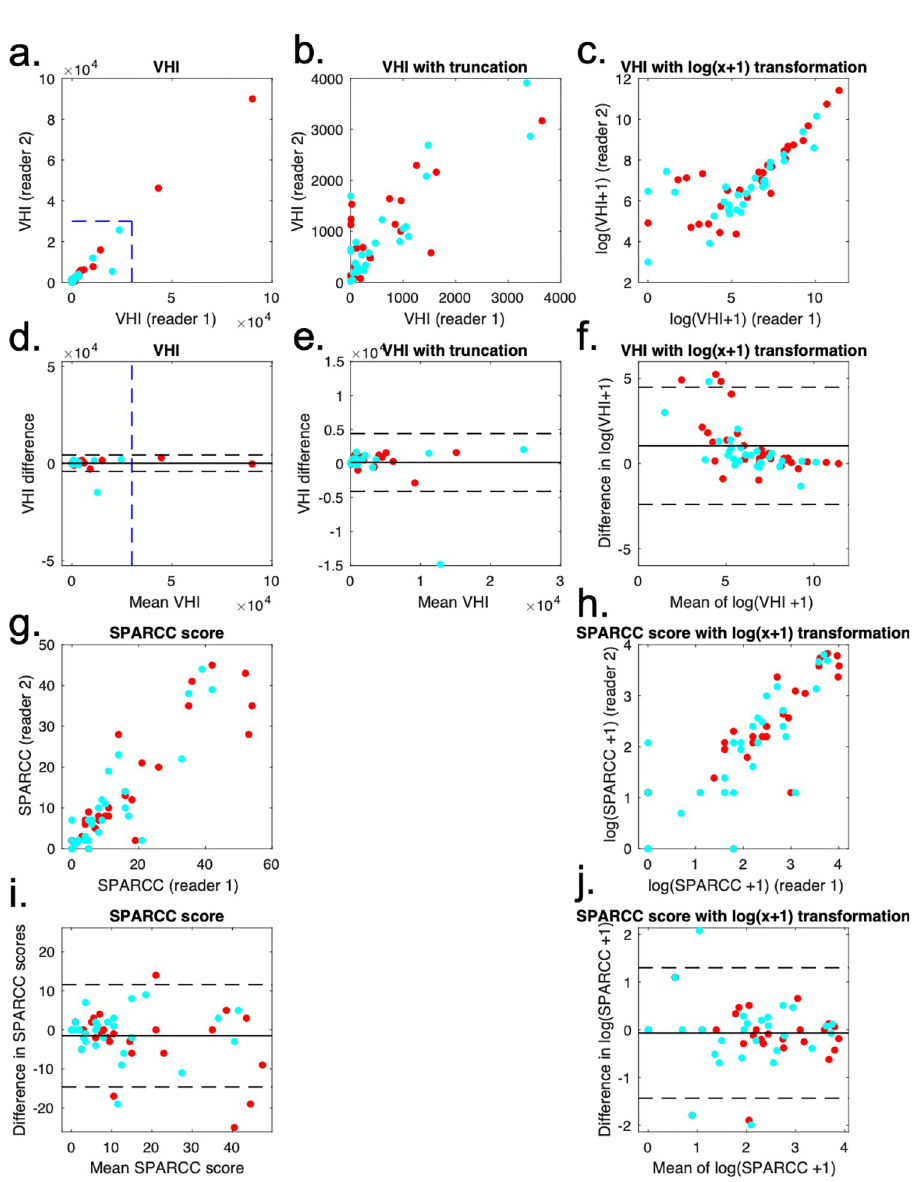
Fig 7. Improvement in inter-observer agreement for V HI . Bland-Altmans plots for the two observers’ scores are shown for VHI (top half) and SPARCC scores (bottom half). Red points refer to pre-treatment scans, and blue points to post-treatment scans. For VHI, the raw voxel counts (left column), voxel counts with truncation of the axes (middle column) and voxel counts with log(x+1) transformation (right-hand column) are shown on scatterplot (top row) and Bland-Altman plots (second row). The truncation points used to generate the middle column figures are shown as blue dotted lines on the plots in the left column. For SPARCC scores, the raw scores (left column) and log(x+1) transformed scores (right column) are shown on scatterplots (third row) and Bland-Altman plots (fourth row).